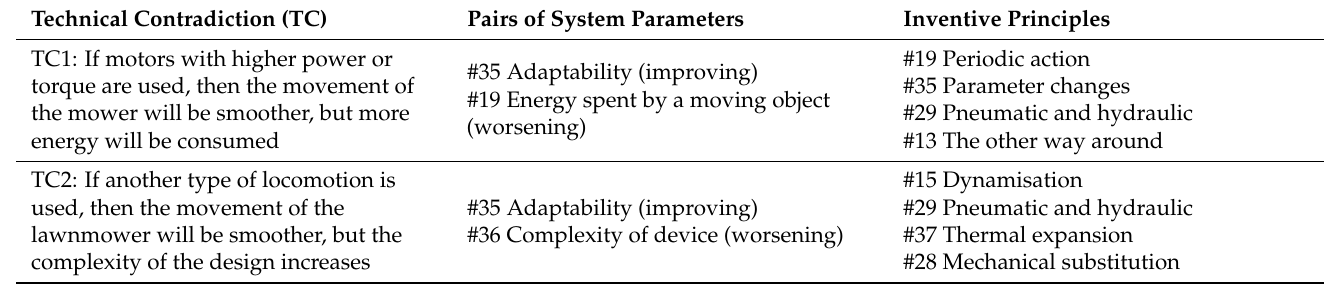
Table 3. Inventive principles from system parameters of technical contradictions (constraint 1).